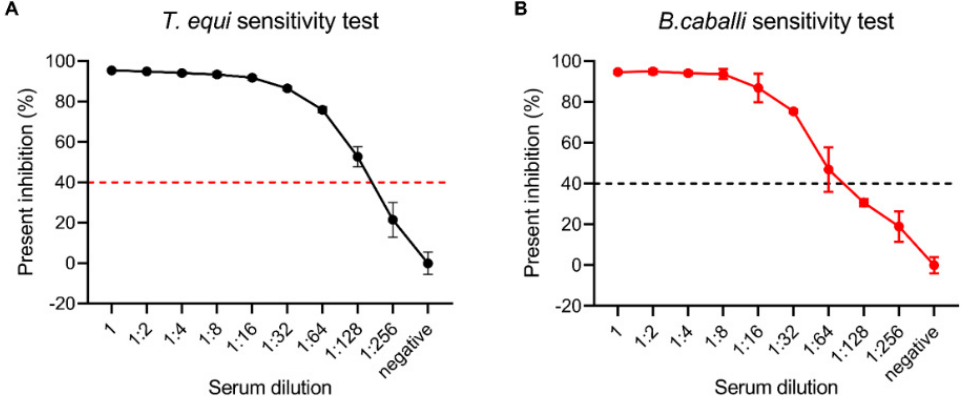
Figure 4. Analysis of the sensitivity of the novel cELISA. Serial two-fold dilutions of positive sera and a negative serum sample were tested with the novel cELISA, and percent inhibition was recorded. ( A ) Performance of the novel cELISA when detecting antibodies against T. equi in T. equi -positive sera at 0:1, 1:2, 1:4, 1:8, 1:16, 1:32, 1:64, 1:128, and 1:256 dilutions, and a negative T. equi serum sample. ( B ) Performance of the novel cELISA when detecting antibodies against B. caballi in B. caballi - positive sera at 0:1, 1:2, 1:4, 1:8, 1:16, 1:32, 1:64, 1:128, and 1:256 dilutions, and a negative B. caballi serum